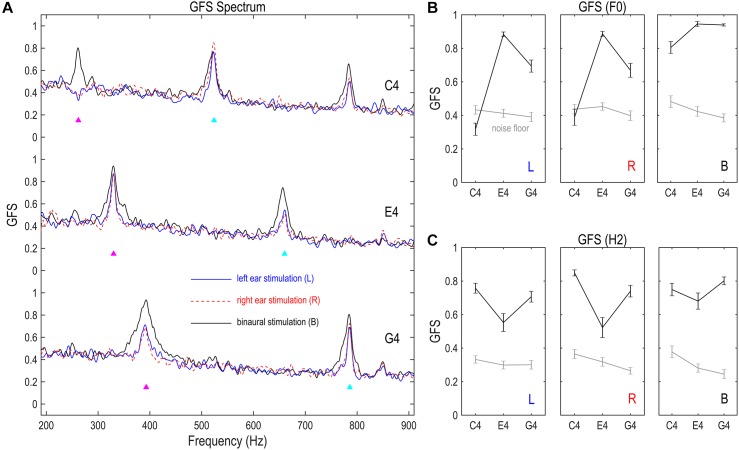
Global field synchronization (GFS) of FFR. (A) GFS spectra of the FFR. (B) GFS of the F0 component. (C) GFS of the H2 component. GFS is a reference- and strength-independent measure of spatial complexity of multichannel FFRs, varying between 1 (perfectly synchronized FFRs across channels) and 0 (completely random response phase across channels). The GFS of both F0 and H2 components significantly exceeds noise floor, except for the F0 component of the FFR monaurally evoked by C4. This indicates a relatively complex source configuration underlying the F0 component of monaurally evoked FFRs to lower stimulus F0s, consistent with the source imaging results. Binaural stimulations lead to lower spatial complexity than monaural stimulations for the F0 component, suggesting possible cancelation between FFR components which renders the sources underlying the F0 component of binaurally evoked FFRs more focal. Importantly, FFR spatial complexity varies with stimulus F0 for the F0 and H2 components of monaurally evoked FFRs and for the F0 component of binaurally evoked FFRs, supporting a varying FFR source configuration with stimulus F0. GFS spectra were smoothed for display. Triangles point to the frequencies of stimulus F0s and twice F0s. GFS of the F0 and H2 components were calculated based on original GFS spectra but not the smoothed ones. Error bars refer to ±SEM.